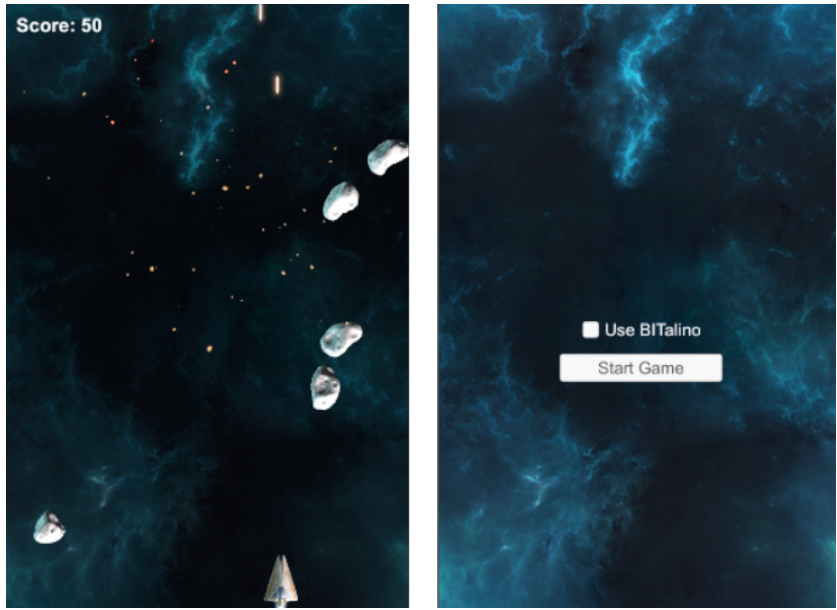
Figure 8. Space Shooter gameplay screenshot